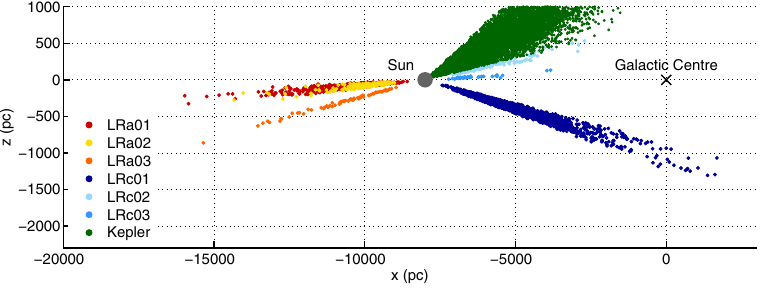
Figure 1. Solar-like oscillating G-K giants observed in several CoRoT fields of view and by Kepler : projection on the x − z plane.